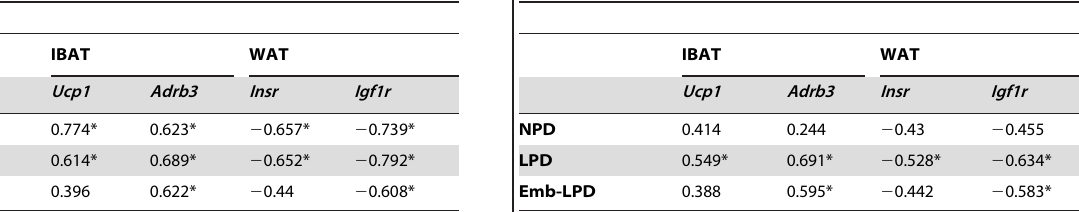
Table 8. Correlations (r values) of body weight at 52 weeks of age with relative real-time RT-PCR expression values from interscapular brown adipose tissue (IBAT) and retroperitoneal white adipose tissue (WAT).